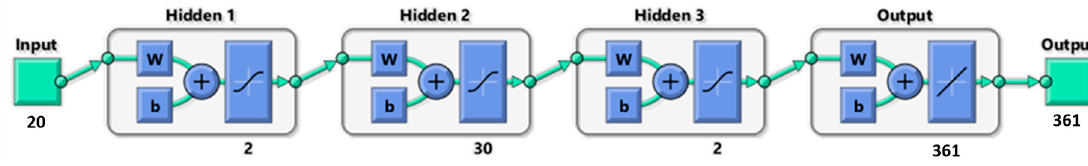
Figure 1. Frequency spectrum of the magnitude of Z in ( f ) computed by the hybrid equivalent circuit and by the PI simulator (PI sim.).